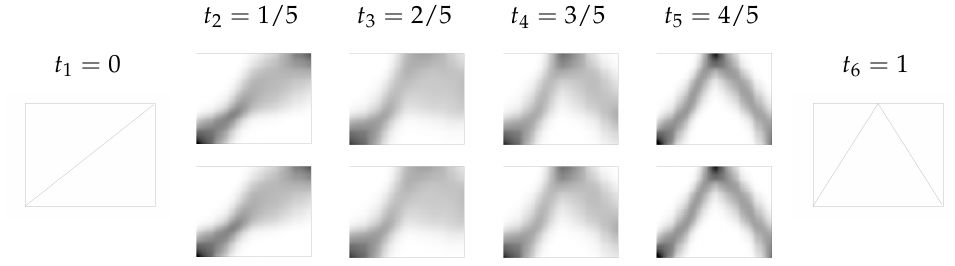
∈ [ 0,1 ] ( y -axis) at time t ( x ) = 1 − x . First row: k , where σ k